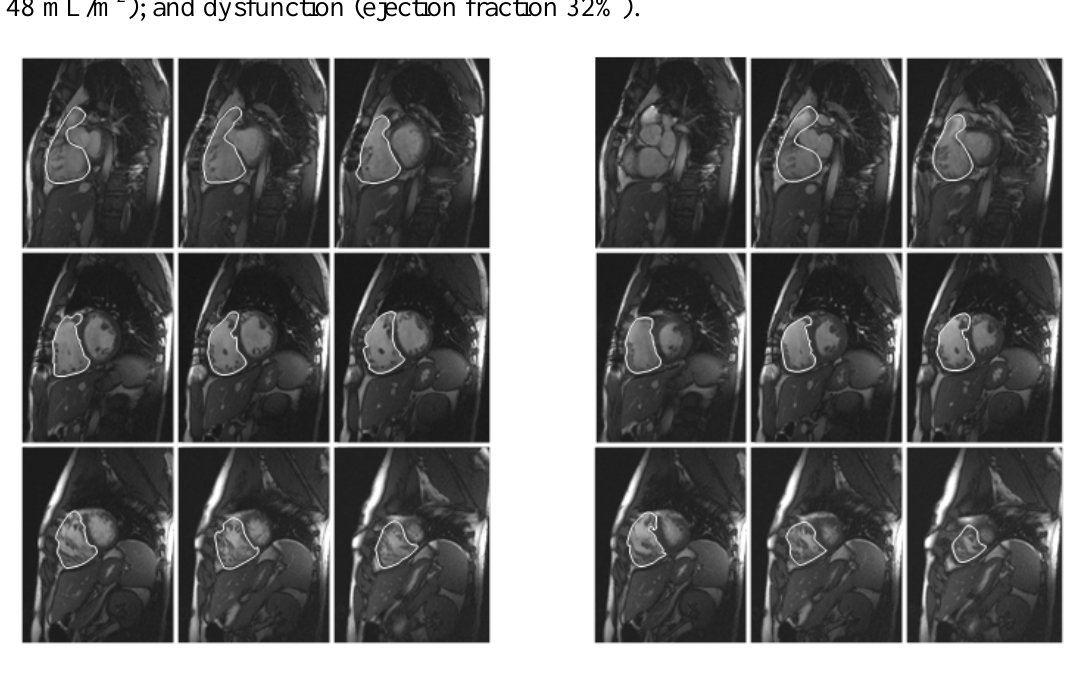
Figure 1. Cardiac magnetic resonance (MR) imaging, trueFISP cine sequence, short-axis views, manual segmentation: end-diastolic (ED; left ) and end-systolic (ES; right ) contours of the right ventricle (RV), at the basal, midventricular, and apical levels, in a patient with repaired Fallot’s tetralogy, showing right ventricular dilatation (end-diastolic volume index 148 mL/m 2 ); and dysfunction (ejection fraction